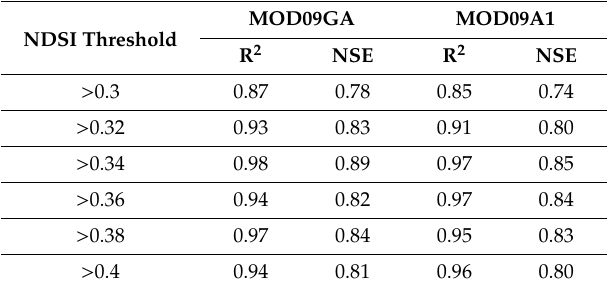
Table 3. Statistical comparison of snow cover area of 120 scenes of MODIS MOD09GA and MOD09A1 products with Landsat ETM + , in situ snow data and Google Earth imagery for fixation of new Normalized Di ff erence Snow Index (NDSI) threshold.